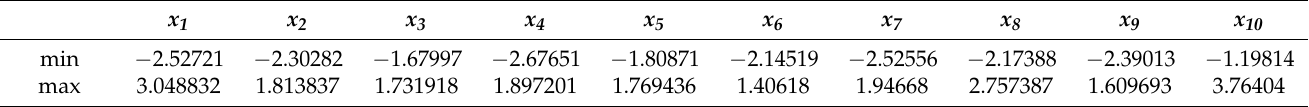
Table 9. Standardized values of optimization constraints for input variables x 1 to x 10